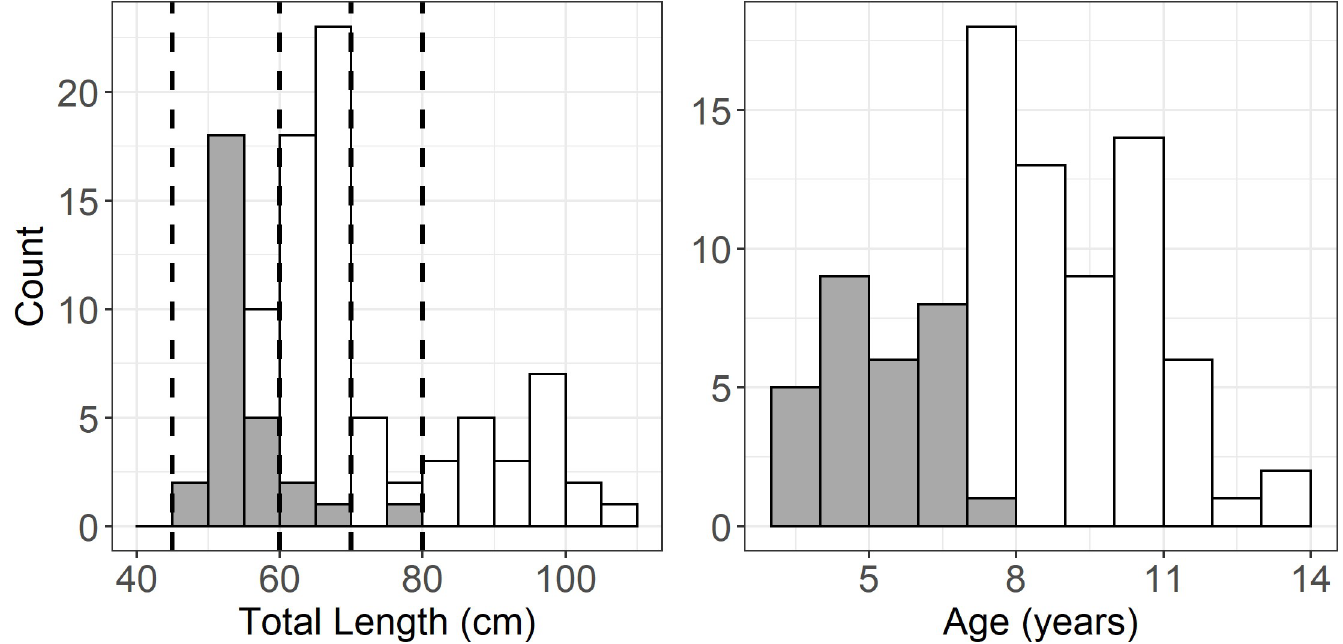
Fig 2. Size (total length, TL) and age distributions of experimental striped bass. Striped bass collected and released during spring in mid-estuary gillnets (open bars) and fall in a down-estuary pound net (filled bars). Dashed lines indicate targeted size strata.